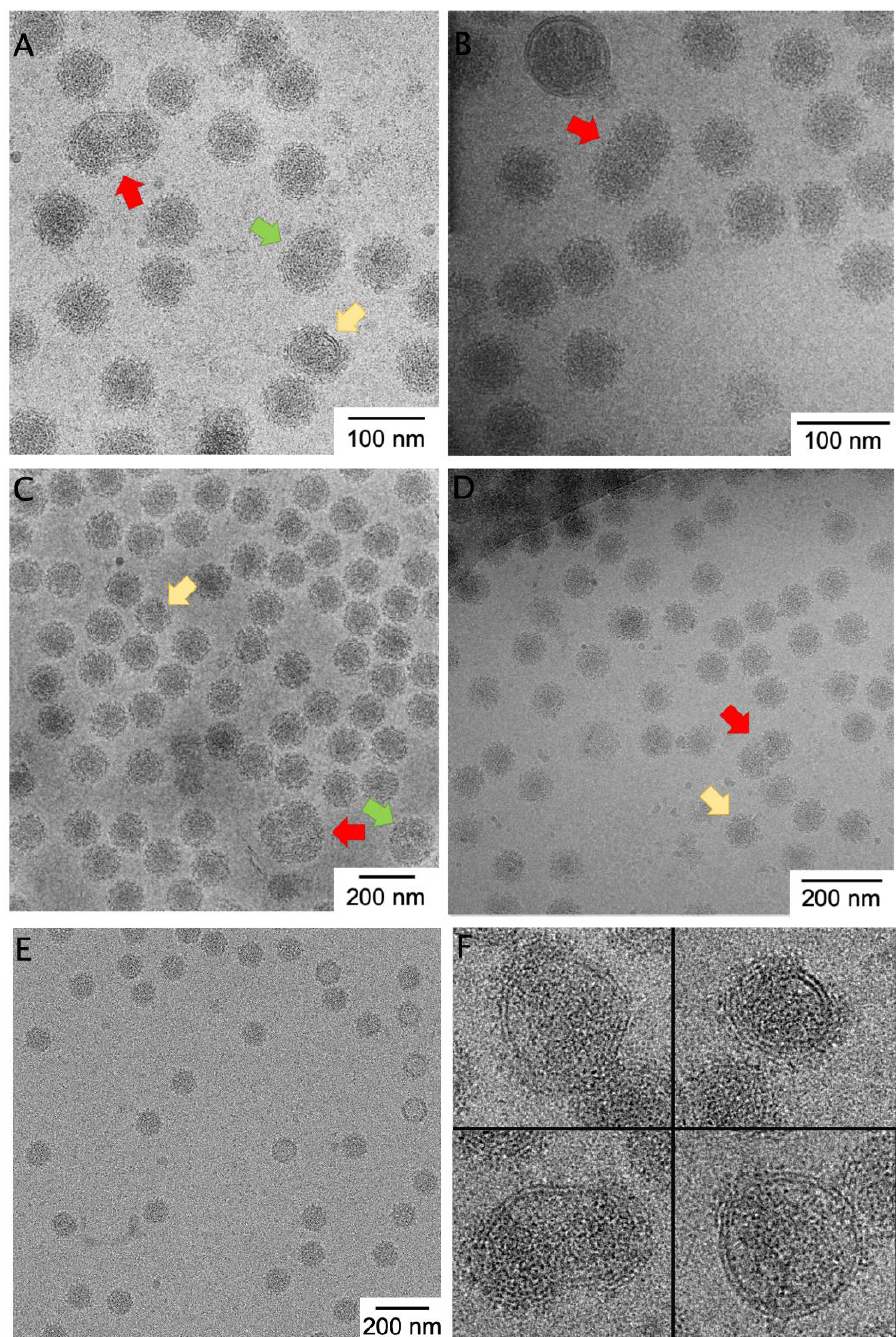
Figure 1. Micrographs of heterogeneous alphavirus preparations. Representative cryo-EM images of ( A ) EILV/EEEV, ( B ) VEEV TC-83, ( C ) EILV/CHIKV, and ( D ) EILV/VEEV purified in the same laboratory by comparable methods, as well as ( E ) the control virus AAV8. Multi-cored particles (red arrow) — particles with two or more NCs inside the viral envelope — were frequently observed in each alphaviral preparation but not in AAV8. Particles bigger (green arrow) and smaller (yellow arrow) than normal were also observed. ( F ) Selected pleomorphic particles of EILV/EEEV illustrate variable spike coverage and nucleocapsid defects which are sometimes, but not always, associated with multiple cores per particle.